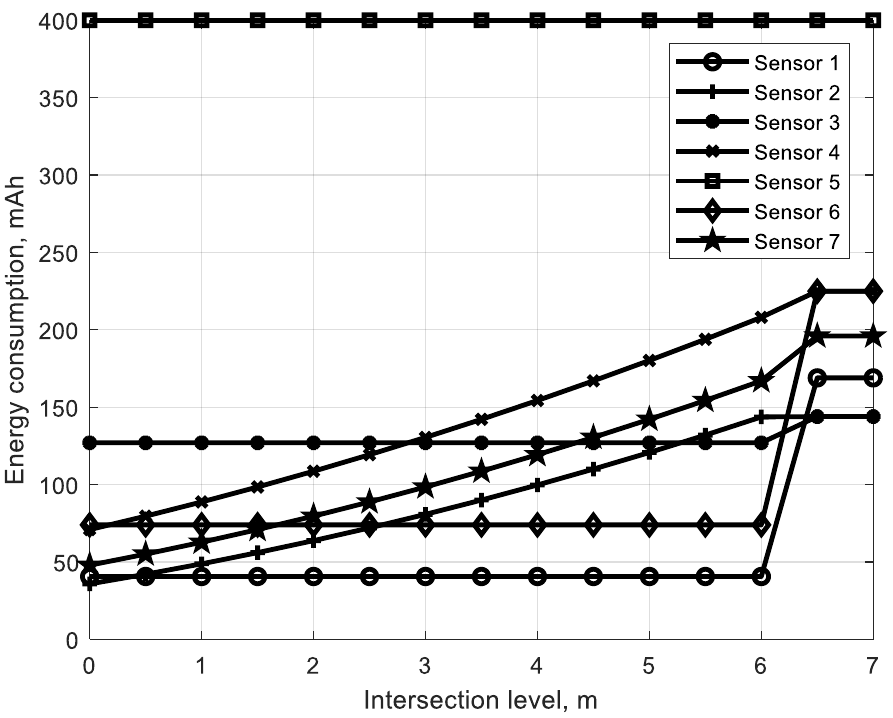
Figure 3. Energy consumption of each sensor depending on the level of intersection of the coverage areas.